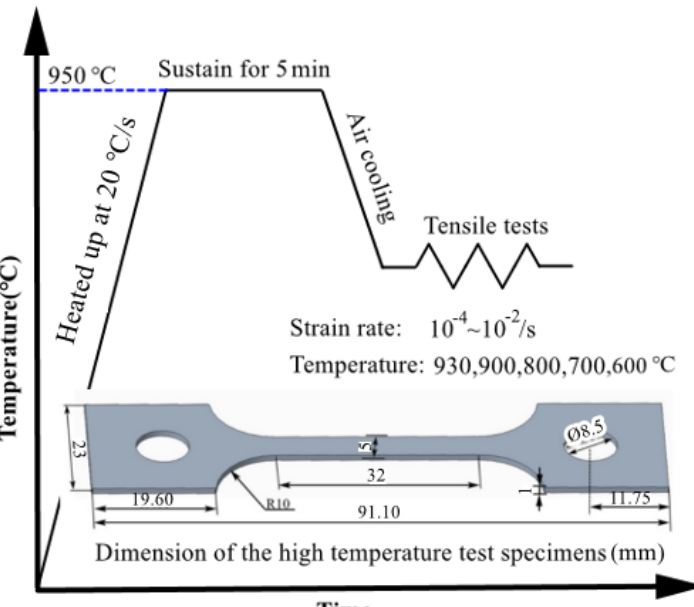
Figure 2. The dimensions of high-temperature tensile tests specimens and experiment process.